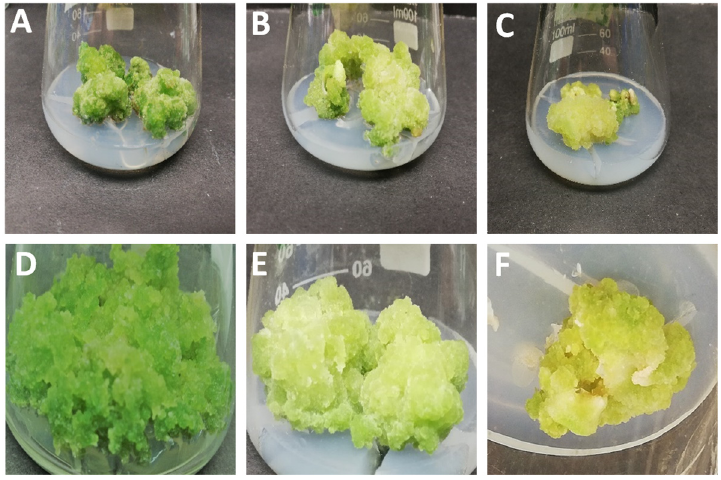
Figure 1. Morphological aspects of callus cultures of L. grandiflorum from stem explants ( A ) 1.0 mg/L NAA ( B ) 1.0 mg/L NAA + 2.5 mg/L TDZ ( C ) 2.5 mg/L TDZ, and from leaf explants ( D ) 1.0 mg/L NAA, ( E ) 1.0 mg/L NAA + 2.5 mg/L TDZ ( F ) 2.5 mg/L TDZ.